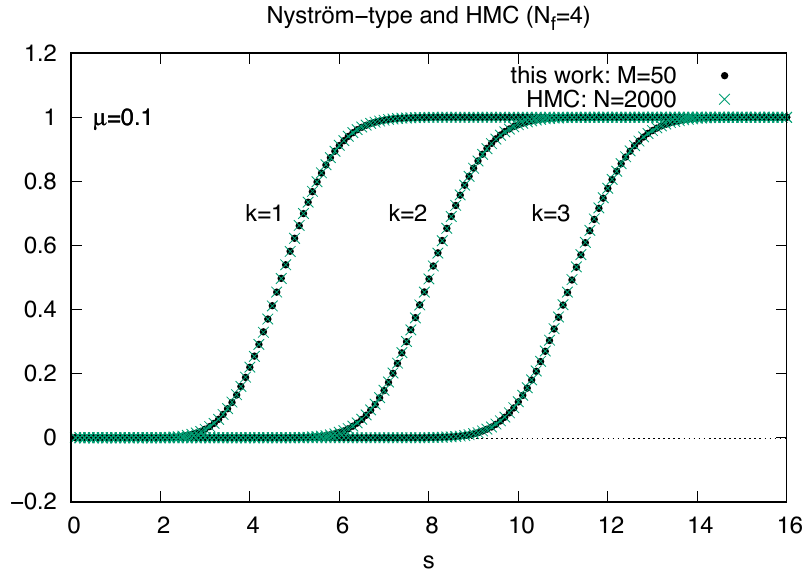
Figure 4 . F k ( s ) ( k = 1 ; 2 ; 3) for N F = 4 quadruply-degenerated mass parameters (cid:22) 1 = 0 : 1 and the topological charge (cid:23) = 0 together with Monte Carlo result. Black dot: Nystr(cid:127)om-type discretization of order M = 50. Green cross: hybrid Monte Carlo simulation with the random matrix rank N =